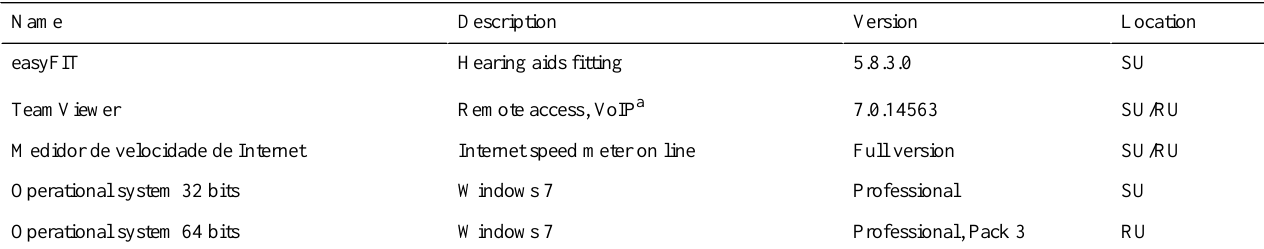
Table 5. Study applications and operating